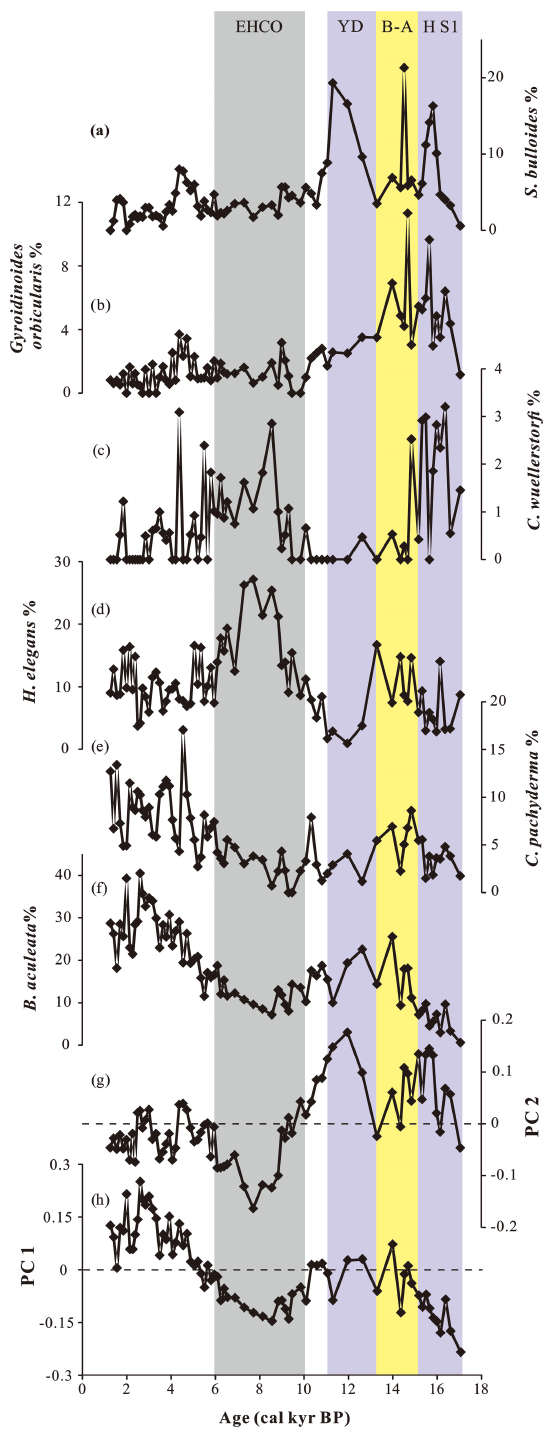
Figure 3. Downcore variations in PC scores and the percentages of major species. (a) Sphaeroidina bulloides and (b ) Gyroidinoides orbicularis are dominated assemblage 3, (c) Cibicidoides wueller- storfi and (d) Hoeglundina elegans are the main associated species of assemblage 2, (e) Cibicidoides pachyderma and (f) Bulimina ac- uleata are major species in assemblage 1. The color-shaded inter- vals and abbreviations are the same as in Fig.